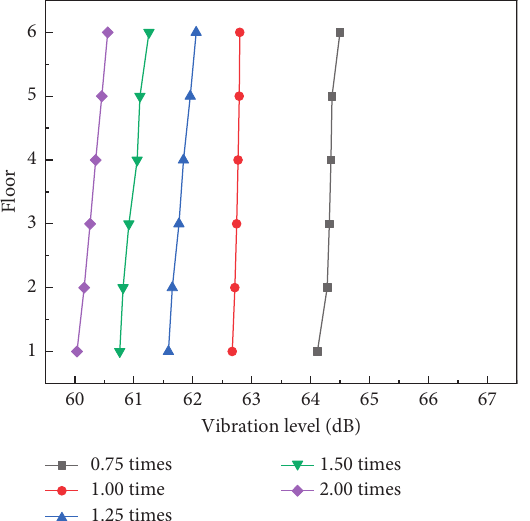
Figure 11: Variation curve of building vibration response with floor under different soil densities.